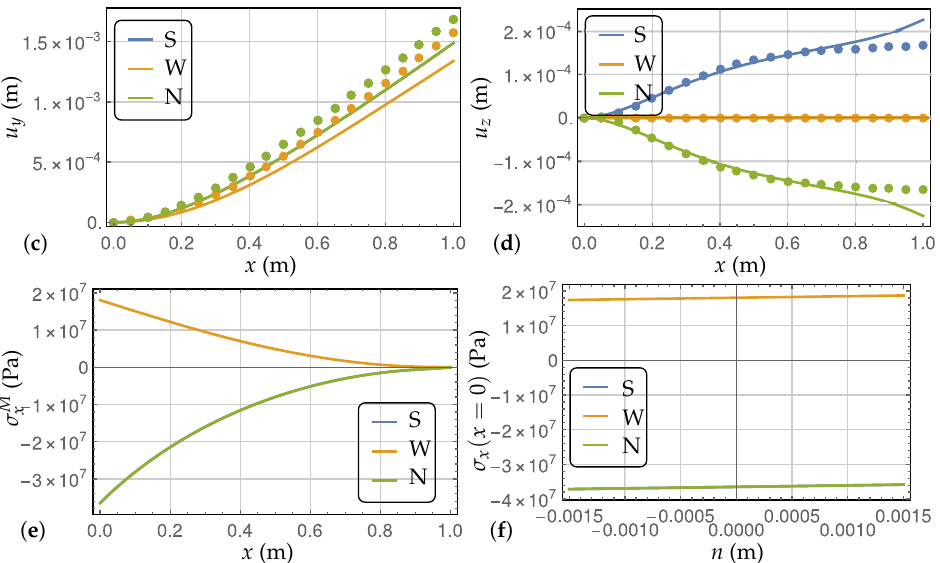
Figure 7. Solution for the load condition 2; S: s = 0; W: s = π R j = 2,5,7; ( b ) displacement u x ; ( c ) displacement u y ; ( d ) displacement u z ; ( e ) stress component σ M x ; ( f ) stress component σ x at x = 0. Solid lines–analytical solution, dotted lines–FE